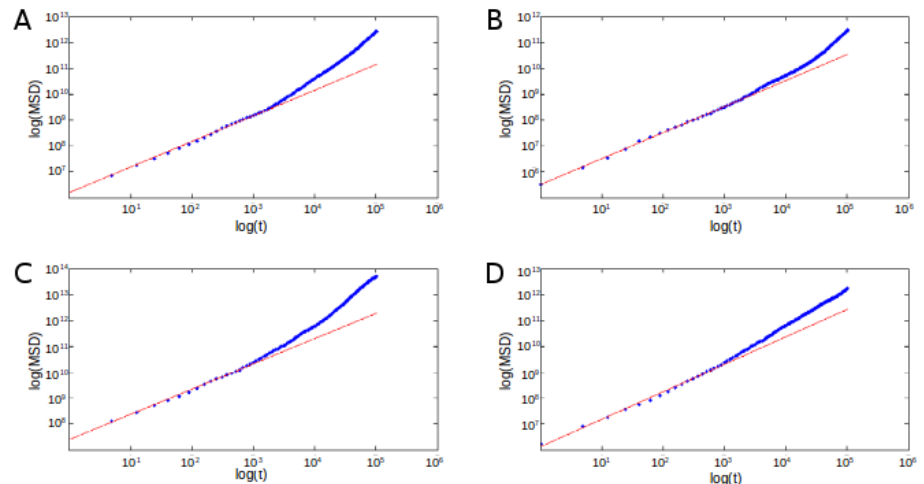
Figure 10. Linear fit to MSD, according to sample MSD method: c 1 ( A , C ); and c 4 ( B , D ); and ( A , B ) normal structure; and ( C , D ) abnormal structure.